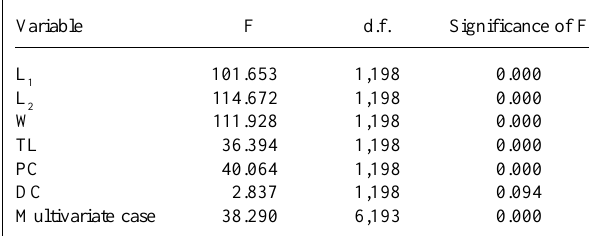
Table V - Effect of temperature on the quantitative variables L and TL and meristic variables PC and DC with the statistical values (F), degrees of freedom (d.f.) and significance levels. Comparison of Eureka 18ºC F